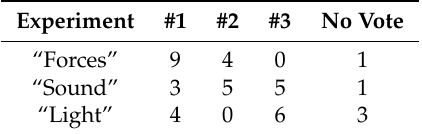
Table 5. Number of group leaders who liked each experiment